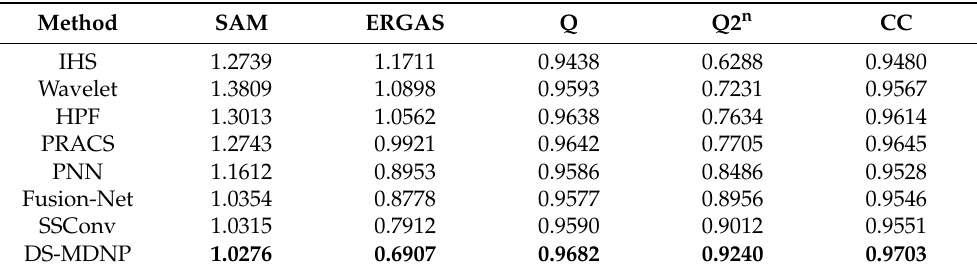
Table 5. Quantitative evaluation comparison of fusion results on the GaoFen-1 dataset. The values in bold represent the best